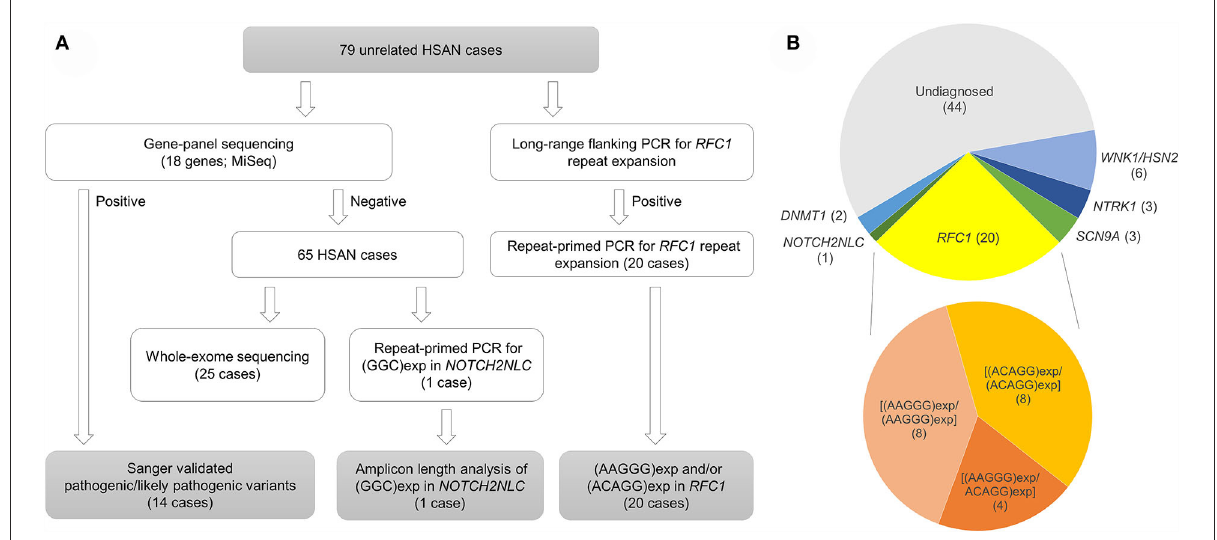
FIGURE1 Genetic analysis workflow (A) and proportional piechart of genes with pathogenic/likely pathogenic variants from diagnosed HSAN patients (B) .